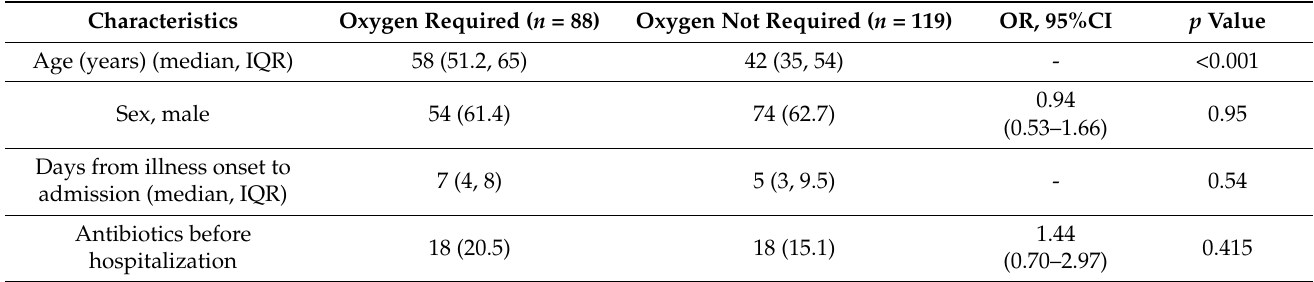
Table 1. Demographics and baseline characteristics of in-patient COVID-19 cases according to oxygen